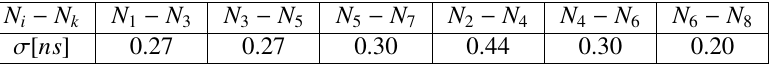
In the case of incoming charged particles in the first layer, we have the signal and practi- cally constant occupancy in all layers. This case is shown in Fig. 6. We have obtained the time resolution for the two closest layers at the deuteron beam energy 3 GeV / nucl. This time resolution is shown in Tab. 1. Table 1. Time resolution for the two closest layers at deuteron energy beam 3 GeV /